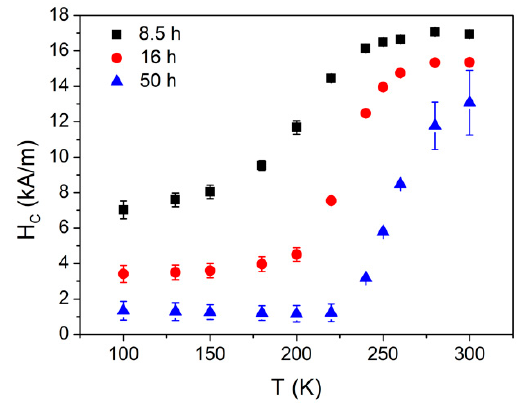
Figure 6. Coercivity as a function of temperature after 8.5, 16, and 50 h of milling.